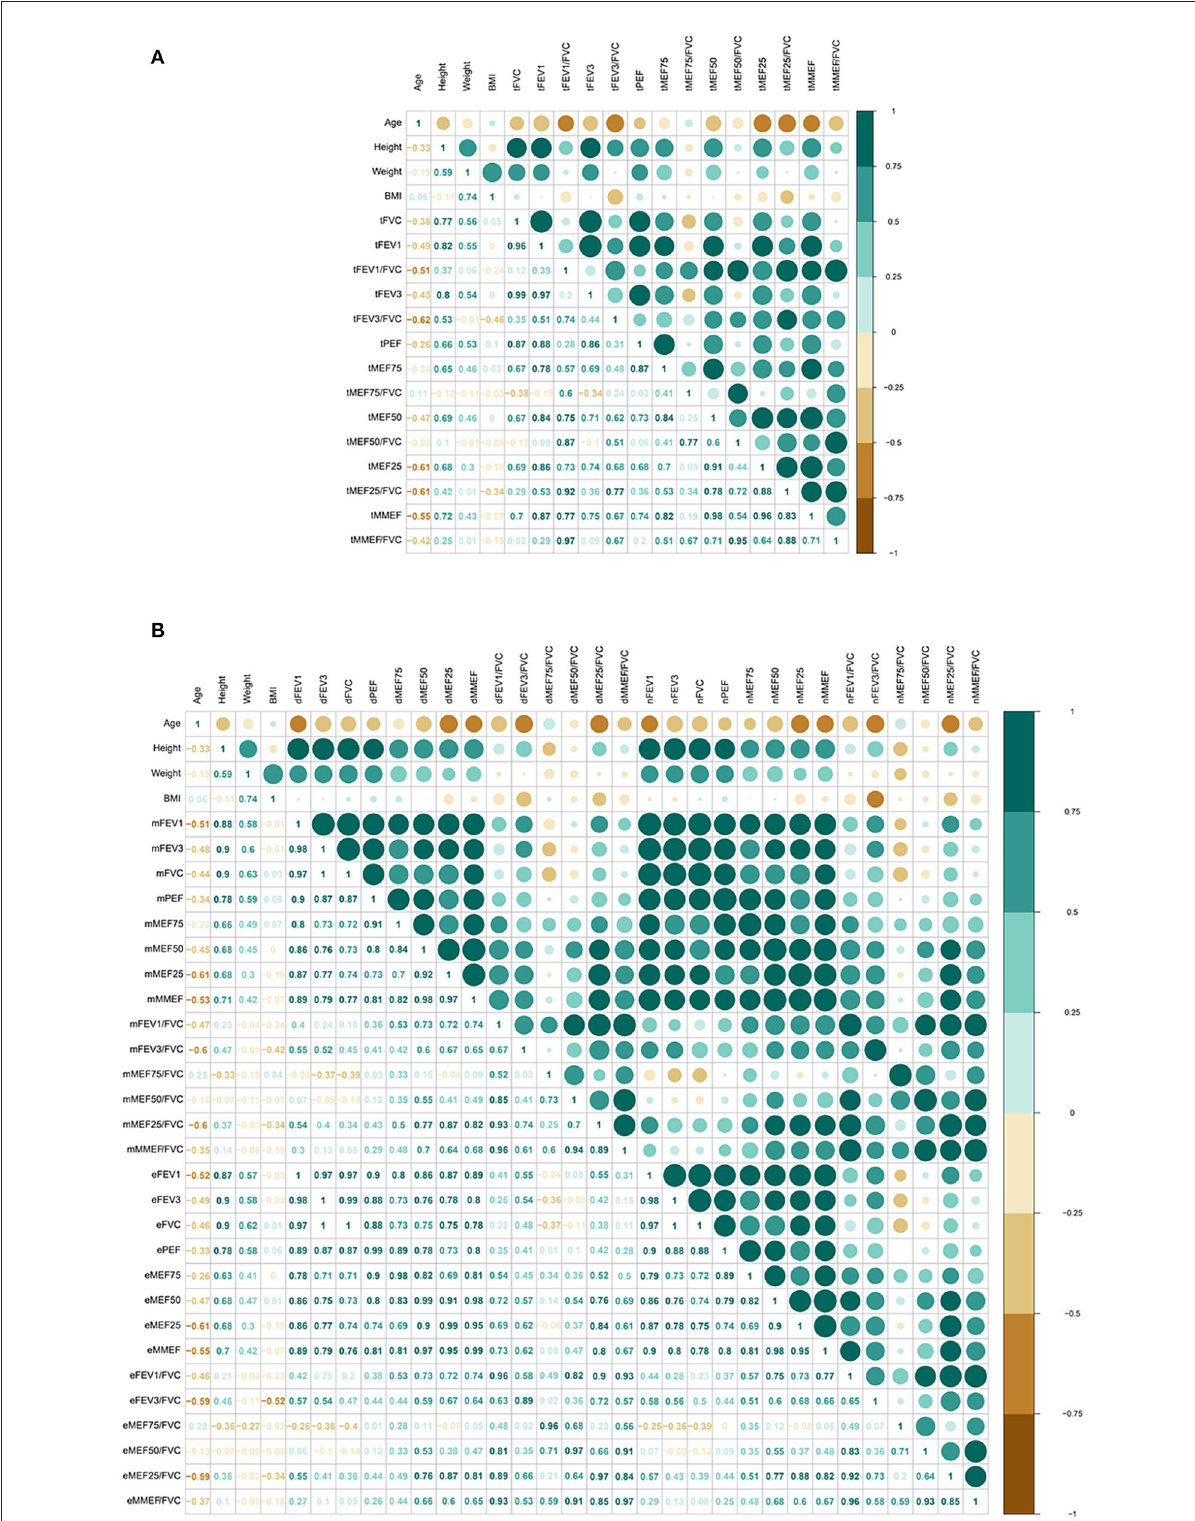
FIGURE2 Correlation of pulmonary function (total, morning, and evening) with age, height, weight, and BMI ( N = 31, except N = 30 for PEF). Both large- and small-airway function variable values were strongly negatively related to age, and were dramatically positively related to height (A) . Similar correlation both in the morning and the evening was found (B) . FVC, forced vital capacity; FEV 1 , forced expiratory volume in 1s; FEV 3 , FEV in 3s;